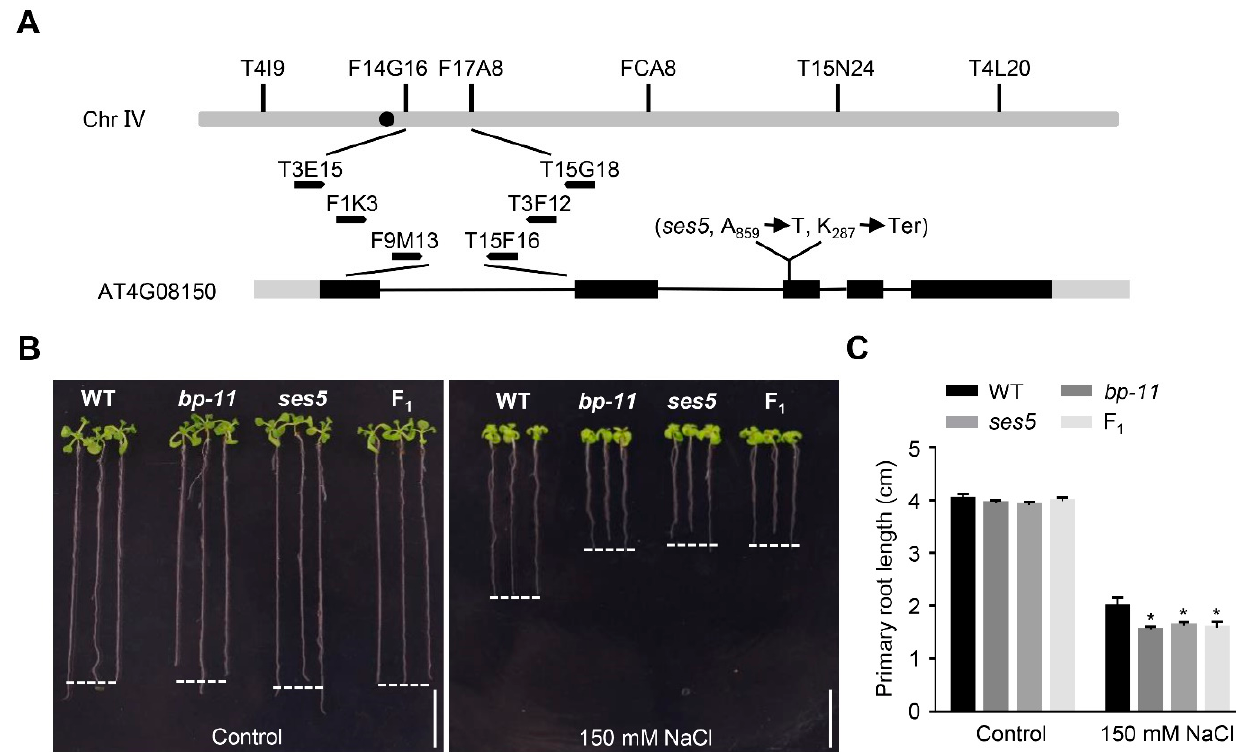
Figure 2. Map-based cloning of SES5 . ( A ) Genetic mapping and genome structure of SES5 . Markers used for the genetic mapping are shown on the top. The black box, gray box, and line indicate the exon, the untranslated region, and the intron, respectively. The mutation in ses5 is shown. ( B ) Photographs of WT, bp-11 , ses5 , and F 1 seedlings grown vertically on control or salt-containing medium. Three-day-old seedlings grown on 1/2 MS medium were transferred to 1/2 MS medium with or without 150 mM NaCl for another 10 d. Scale bar = 1 cm. ( C ) Primary-root length of the seedlings in ( B ). The bars indicate means ± sd of three independent replicates. * p < 0.05 (Student’s t test).